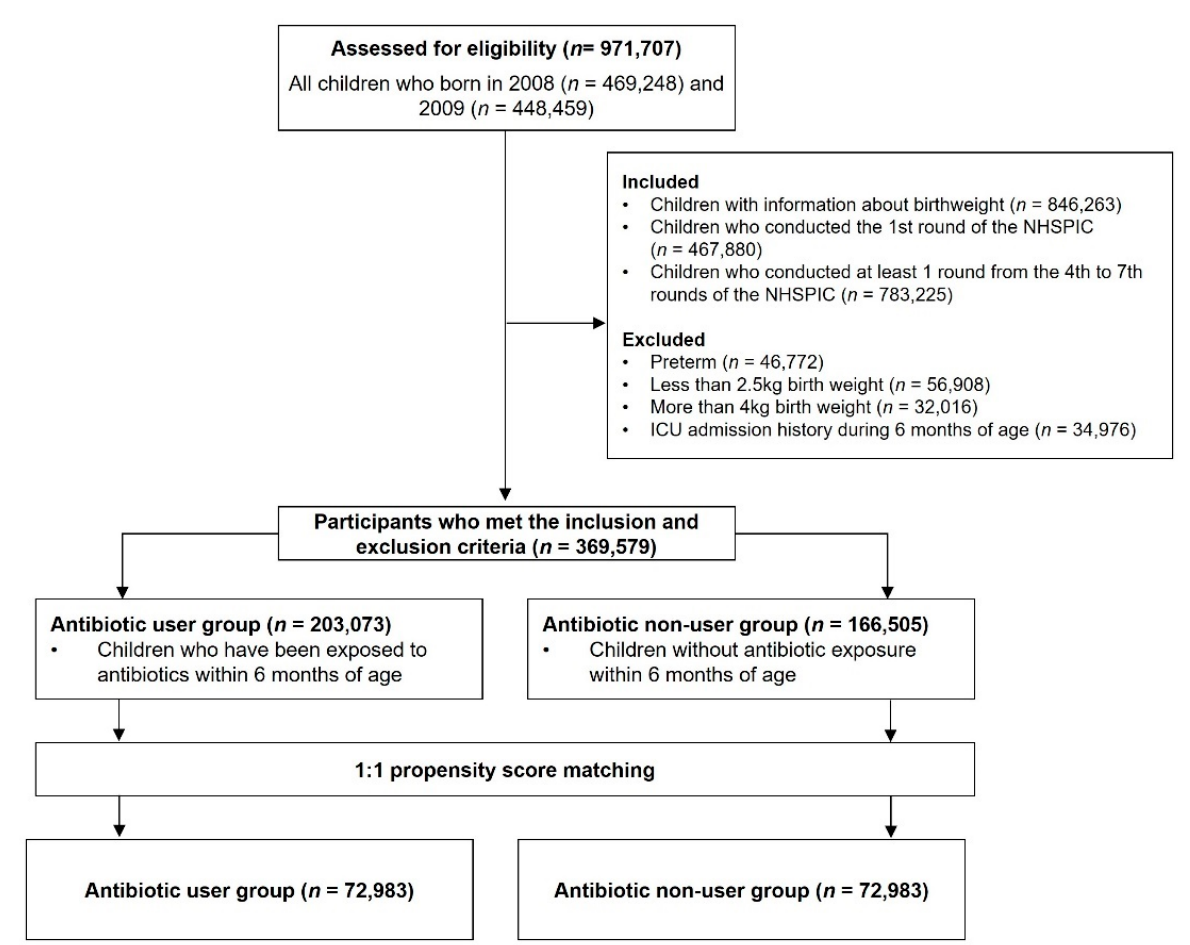
Figure 1. Enrollment, assessment of eligibility, and PS matching of antibiotic users and non-users. To assess the robustness of the results, an additional cohort consisting of users and non-users of antibiotics within 3 months after birth was also analyzed (Supplementary method and Figure